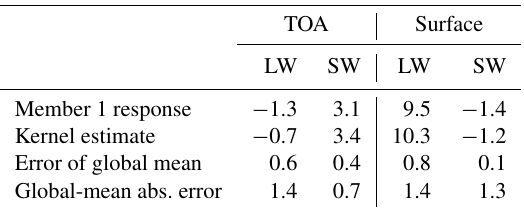
gions of large error associated with tropical clouds, and at the TOA, there is a bias over